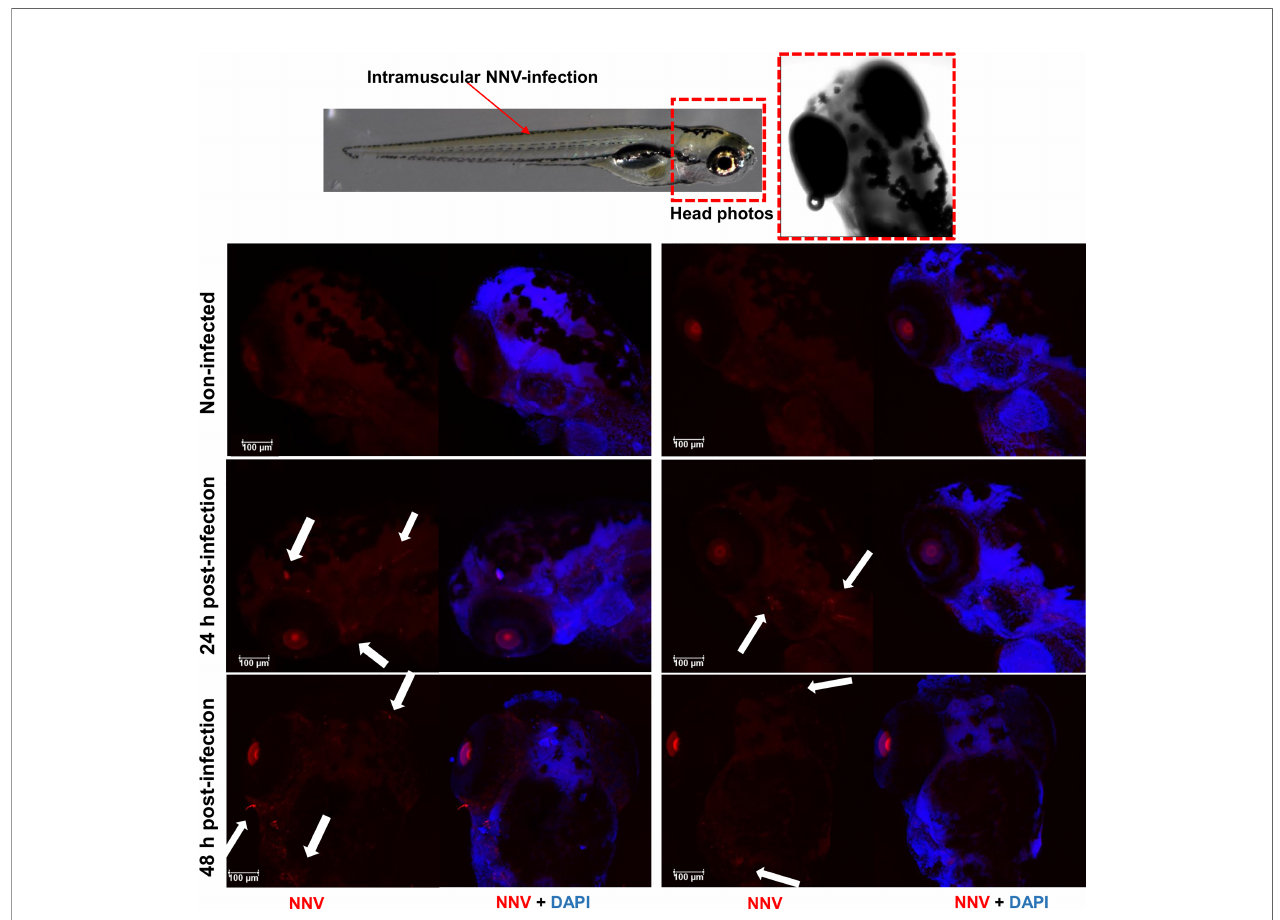
FIGURE 3 | Whole-mount immuno fl uorescence of zebra fi sh larvae infected by intramuscular microinjection with NNV. Confocal images of the head from uninfected and NNV-infected larvae at 24 and 48 hpi. NNV particles are stained red, and cell nuclei are stained blue (DAPI). White arrows denote the position of NNV-infected